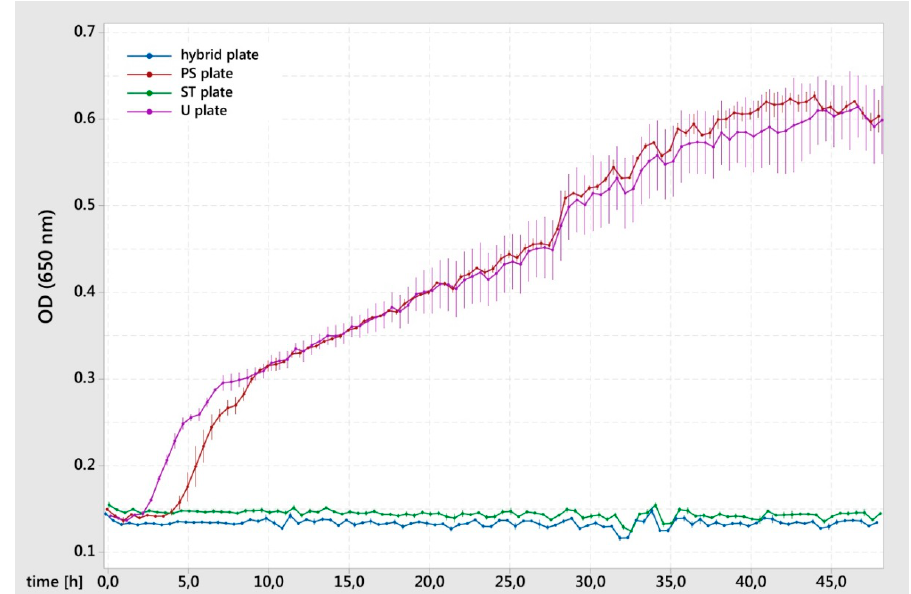
Figure 3. Proliferation of Escherichia coli after 24-h direct contact with the test surface. The means and standard errors of 3 (hybrid plates and ST plates) or 2 (PS plates and U plates) replicates are shown.